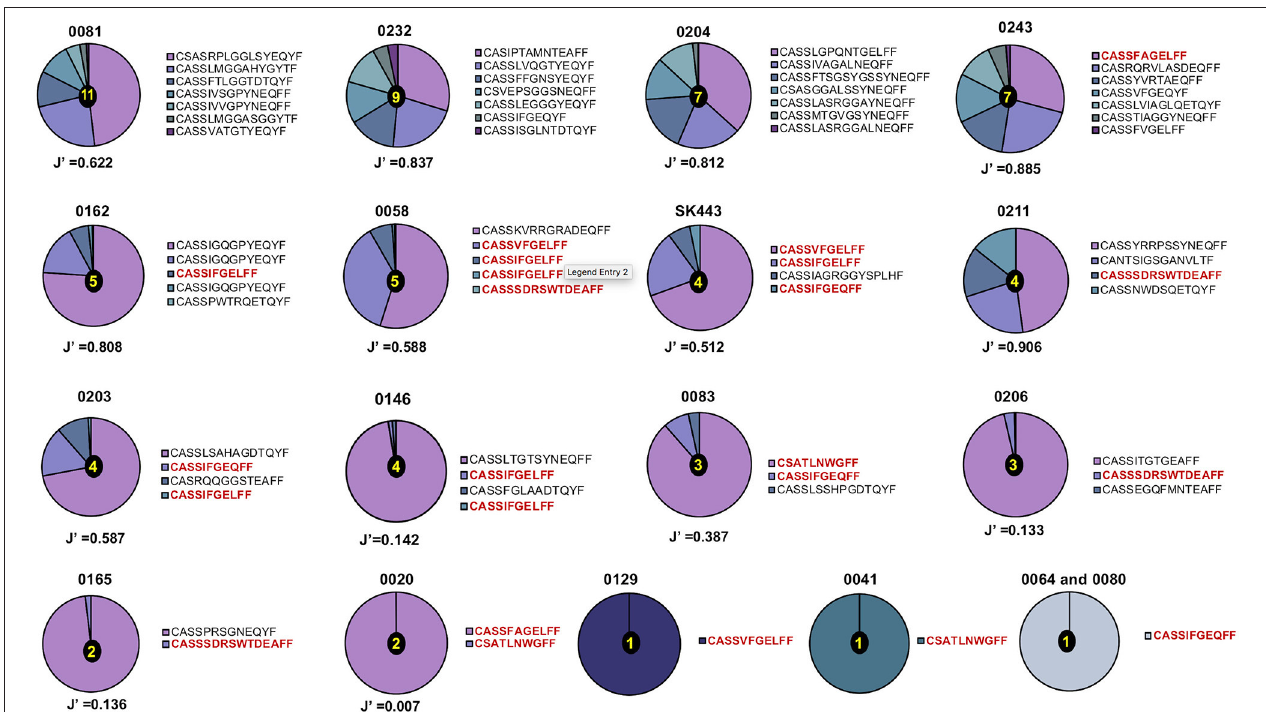
FIGURE 2 | Distribution of TCR- β chain clonotypes in HLA-B*44:03/NW8-specific CD8 + T cells. The frequency distribution of TCR- β chain amino acid sequences obtained from ( n = 18) CMV-infected individuals is shown as pie charts. Frequencies of individual clonotypes are calculated as a percentage of aligned sequencing reads. Amino acid sequences of CDR3 loops are shown on the right of each pie, with public CDR3 clonotypes in bold red. Patient IDs are shown above each pie chart. Shannon’s evenness index (J ′ ) is shown under each pie chart. The number in the centre of each pie indicates the total number of clonotypes seen in the corresponding patient. Colours are assigned randomly and do not correspond to a fixed a